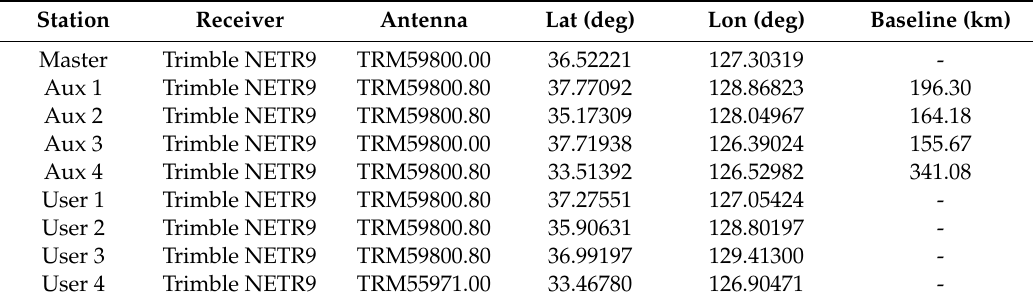
Table 2. Reference station and user information. Baseline length is listed for auxiliary